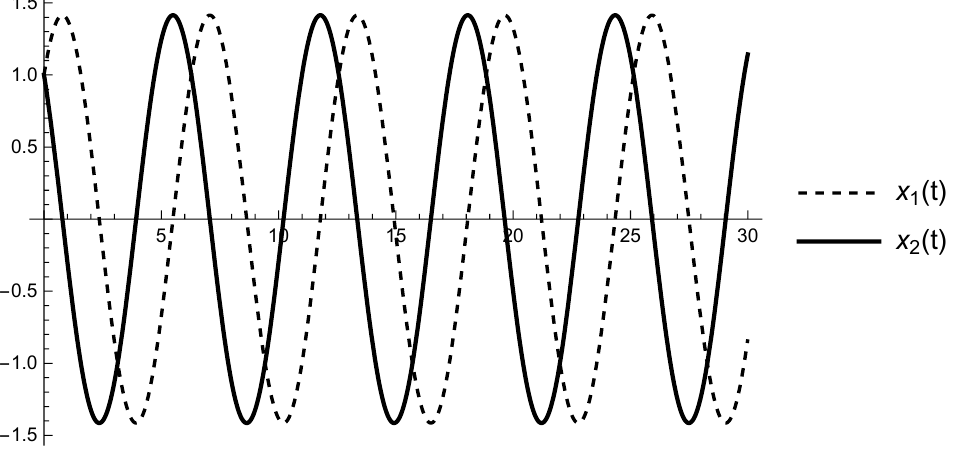
Figure 1. Graph of the solutions (37) for ρ = 1, g 2 ( t ) ≡ − 1.